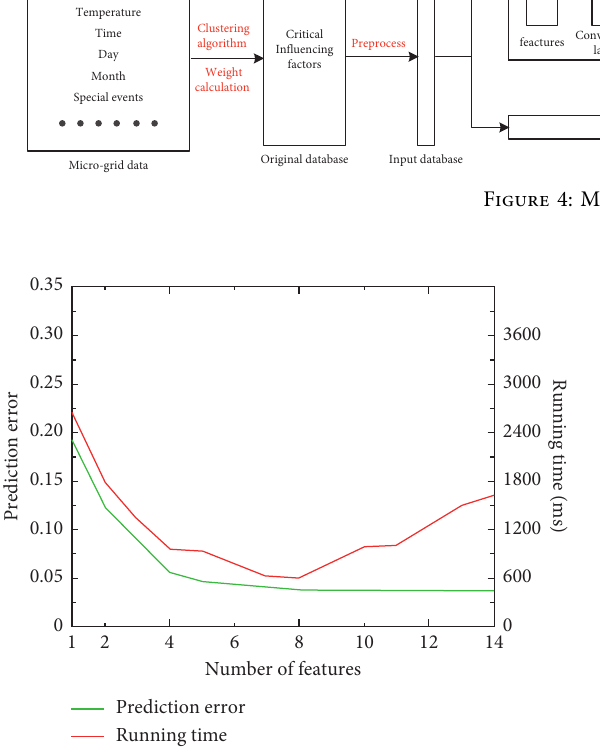
Figure 5: Prediction results and running time under different number of features.